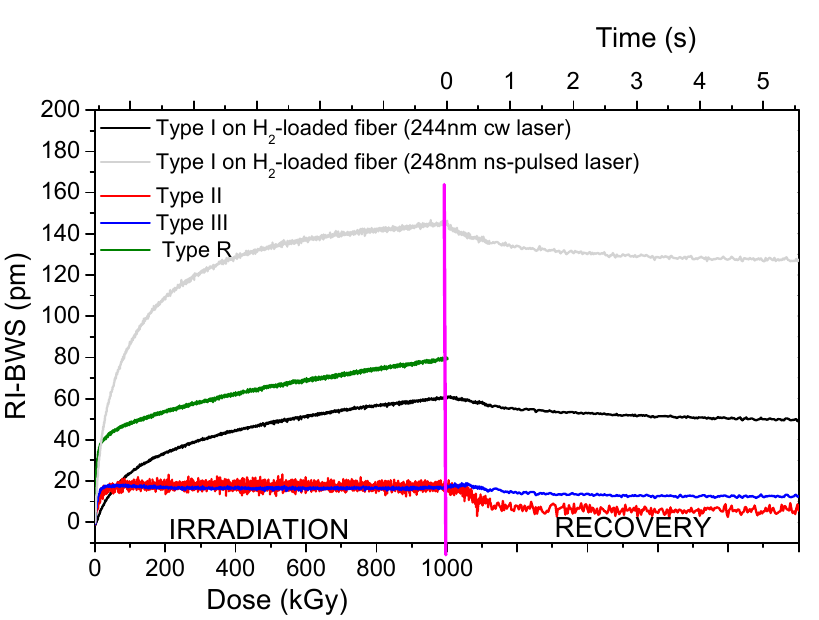
Figure 7. RI-BWS recorded up to 1 MGy at RT on different FBG types written in the same Corning SMF28e+ fiber: two type I FBGs, one written with a CW UV laser (at 244 nm, power density of 4.15 W/cm 2 ) and the other with a 10 ns-pulsed UV laser (at 248 nm, pulse energy of 380 mJ/cm 2 ), in a pre-H 2 -loaded sample; a type II FBG, written through a PM with an fs-IR laser (at 800 nm, a pulse width of 150 fs, and pulse energy of 560 µ J); a type III FBG, written PbP with an fs-IR laser (at 800 nm, a pulse width < 120 fs, and pulse energy of 230 nJ); an R-FBG, manufactured from a type I grating written with a 20 ns-pulsed UV laser (at 248 nm and pulse energy of 9 mJ) and regenerated at 750 ◦ C. The vertical pink line indicates the irradiation end. The dose rate was always 50 Gy/s for all the gratings except for the regenerated one at 10 Gy/s. Data extracted from [74,83].